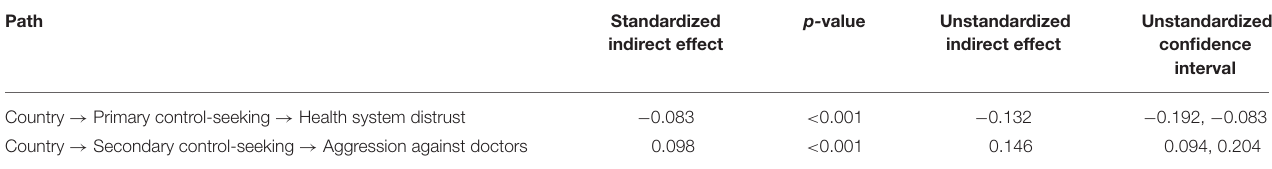
TABLE 6 | Analyses of indirect effects for the COVID-19 healthcare uncertainty scenarios (Study 2). Path